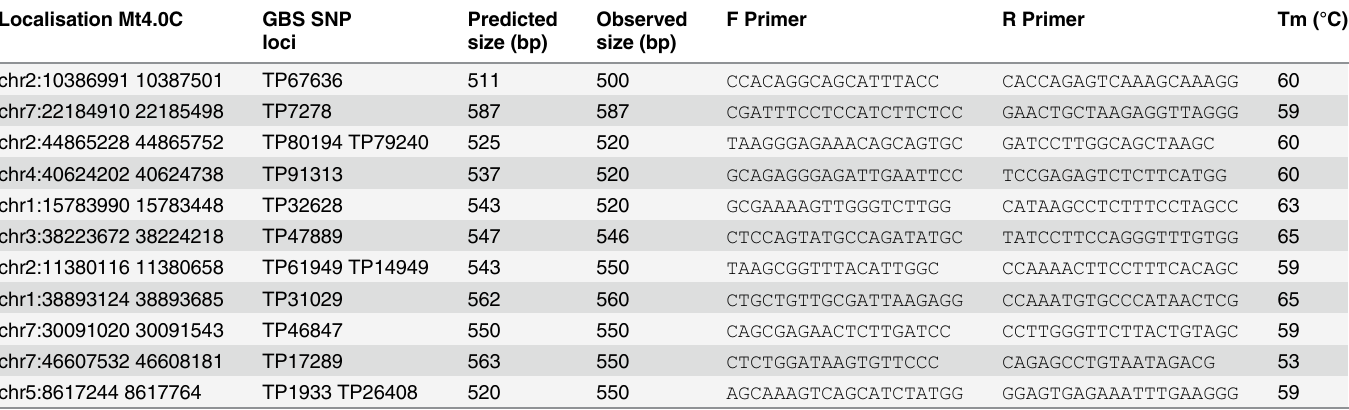
Table 1. PCR primers with respective Tm (°C) for the amplification of genome regions of M . sativa covering SNP loci identified with GBS. Localisation